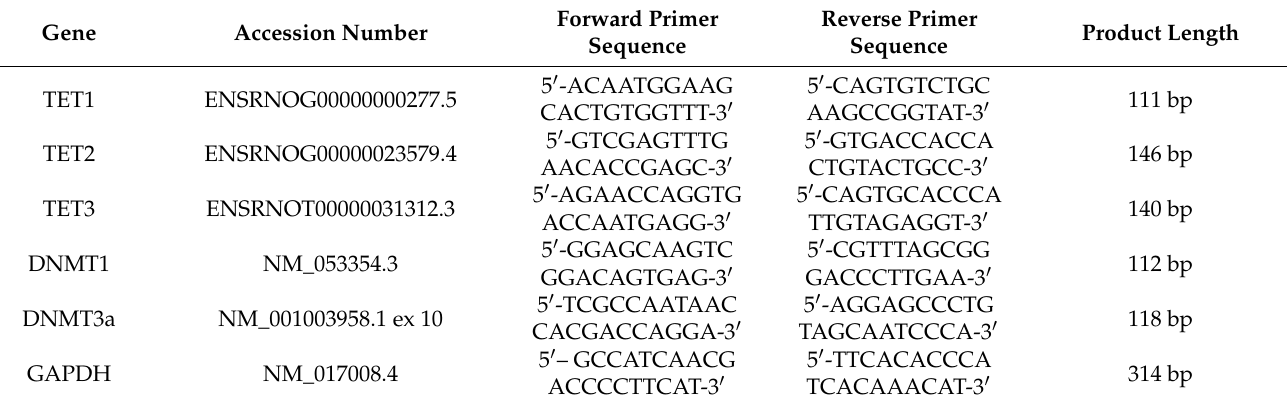
Table 1. List of primer sequences used in the